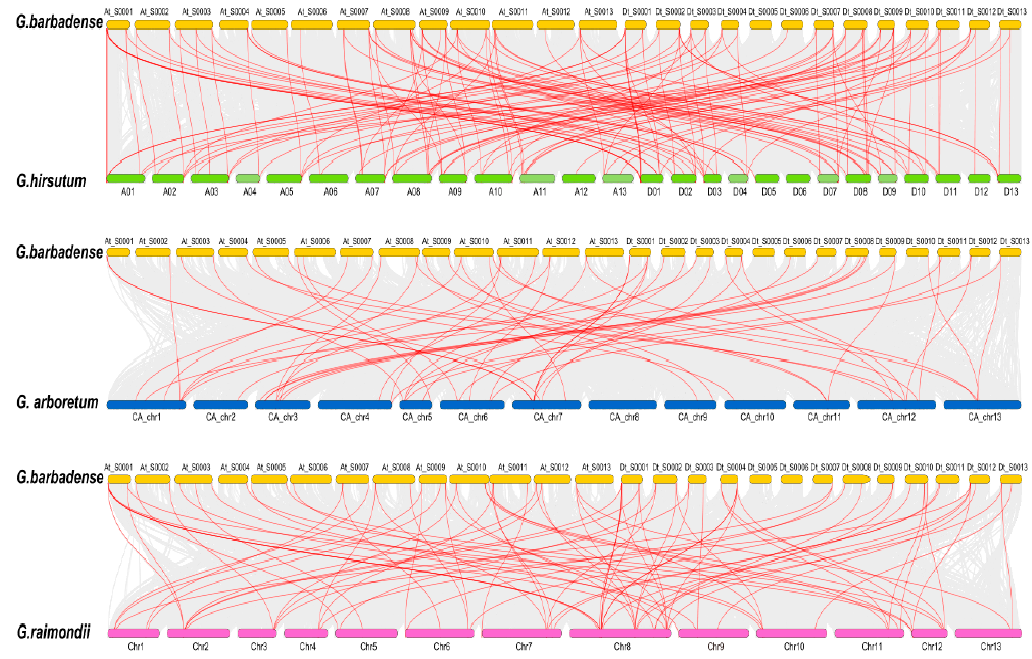
Figure 5. Collinearity analyses of CYP genes between G. barbadense and G. hirsutum , G. arboretum and G. raimondii . Duplication events within G. barbadense and the genomes of the other three Gossypium species are indicated with grey lines in the background, while the red lines highlight syntenic CYP gene pairs.